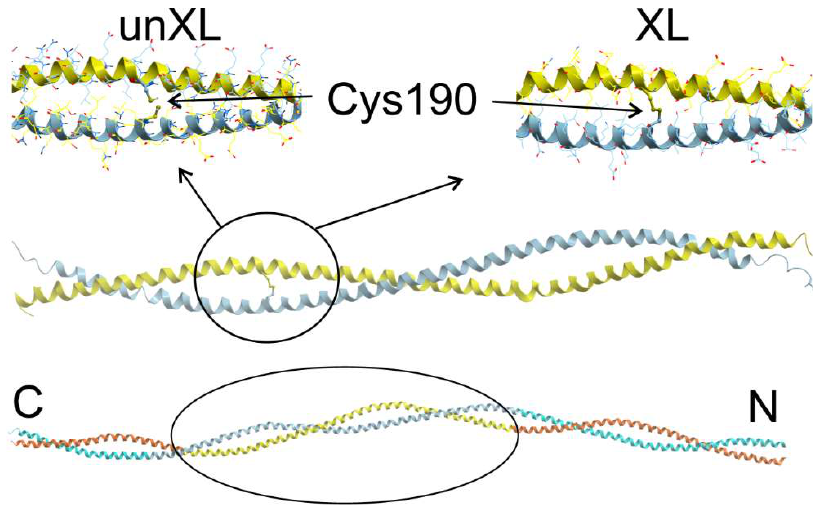
Figure 1. Close view on the snapshots of the MD trajectories in the vicinity of the Cys190 residues for uncross-linked (un-XL) and cross-linked (XL) Tpm are shown in top insets. The middle part of Tpm used for MD simulations is shown in the middle. The position of the middle part of Tpm used for MD simulations in whole Tpm molecule is shown in the bottom with marked N- and C-terminals. The